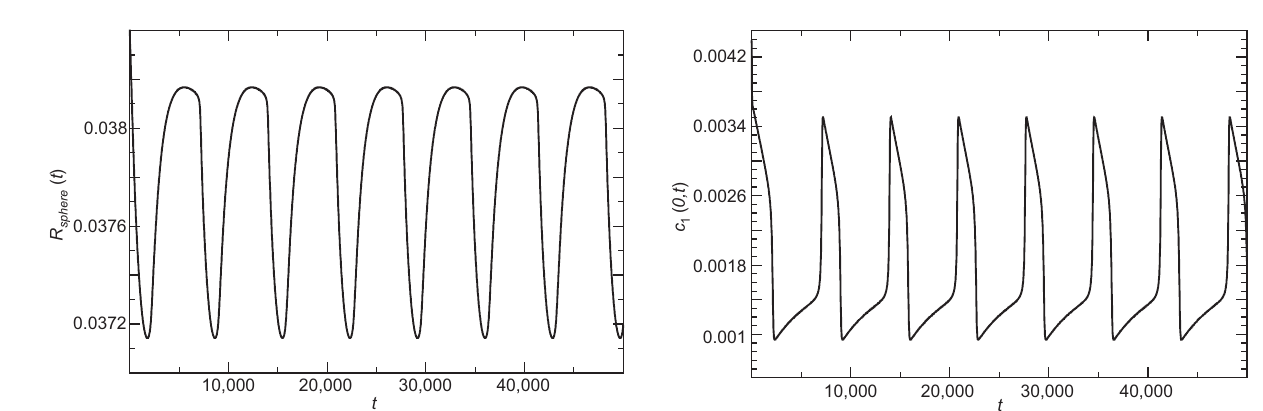
Figure 6 Temporal evolution of the concentration c ter of the